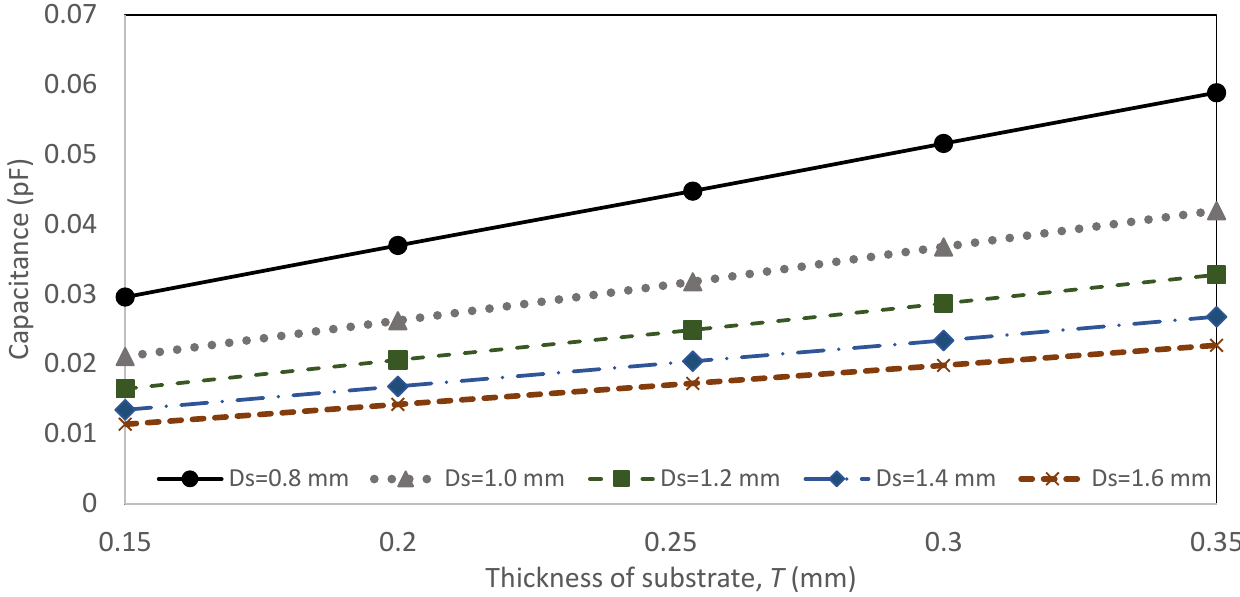
Figure 3. Via hole capacitance as a function of thickness of substrate, T and different diameter of the circular slot, Ds .